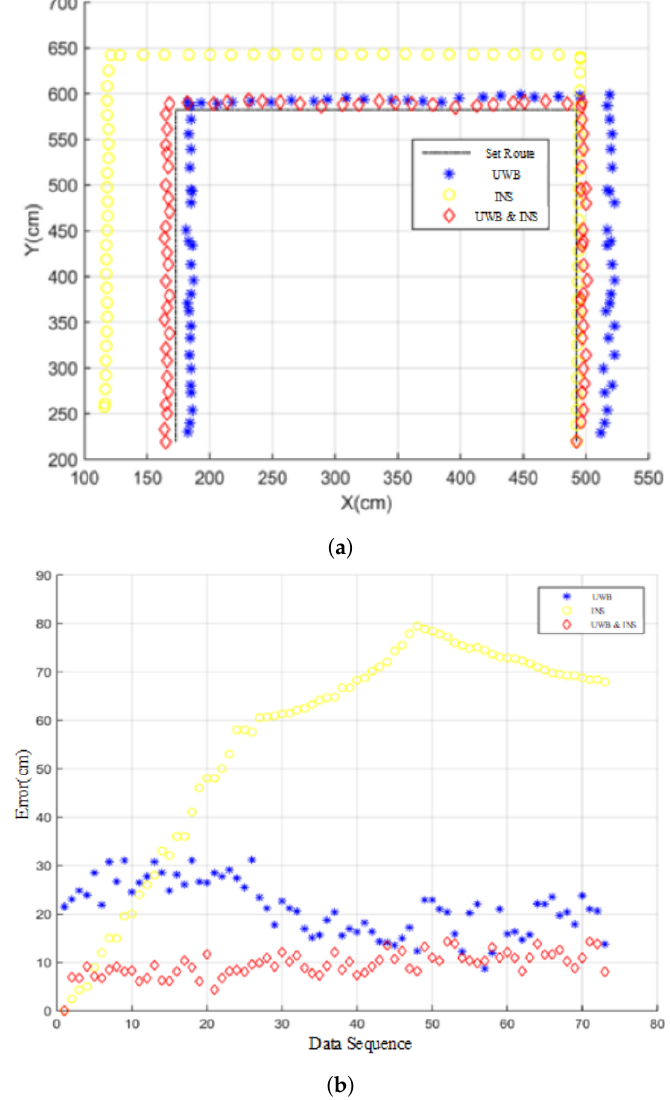
Figure 10. ( a ) route comparison method; ( b ) error comparison of different localization